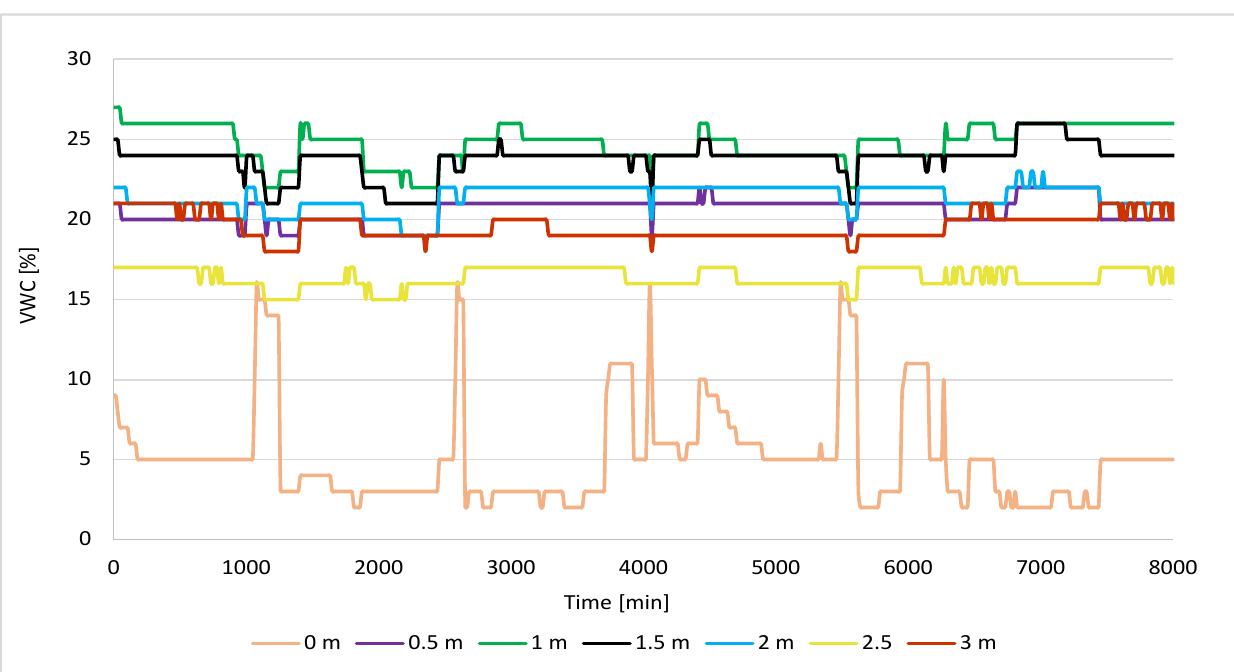
Figure 10. Measured VWC at different depths.